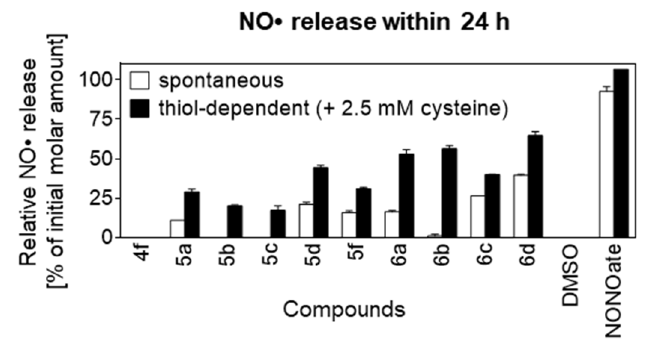
Figure 3. Spontaneous and thiol-dependent NO • release from NO-COXIBs; measured using fluorometric Griess assay ( n = 2); relative release indicates the percentage of soluble nitrogen species (nitrate + nitrite) detected in the incubation buffer after 24 h compared to the initial molar amount of compounds; NO • release of NONOate (positive control) exceeded the maximum detection limit; data presented as mean ± range.